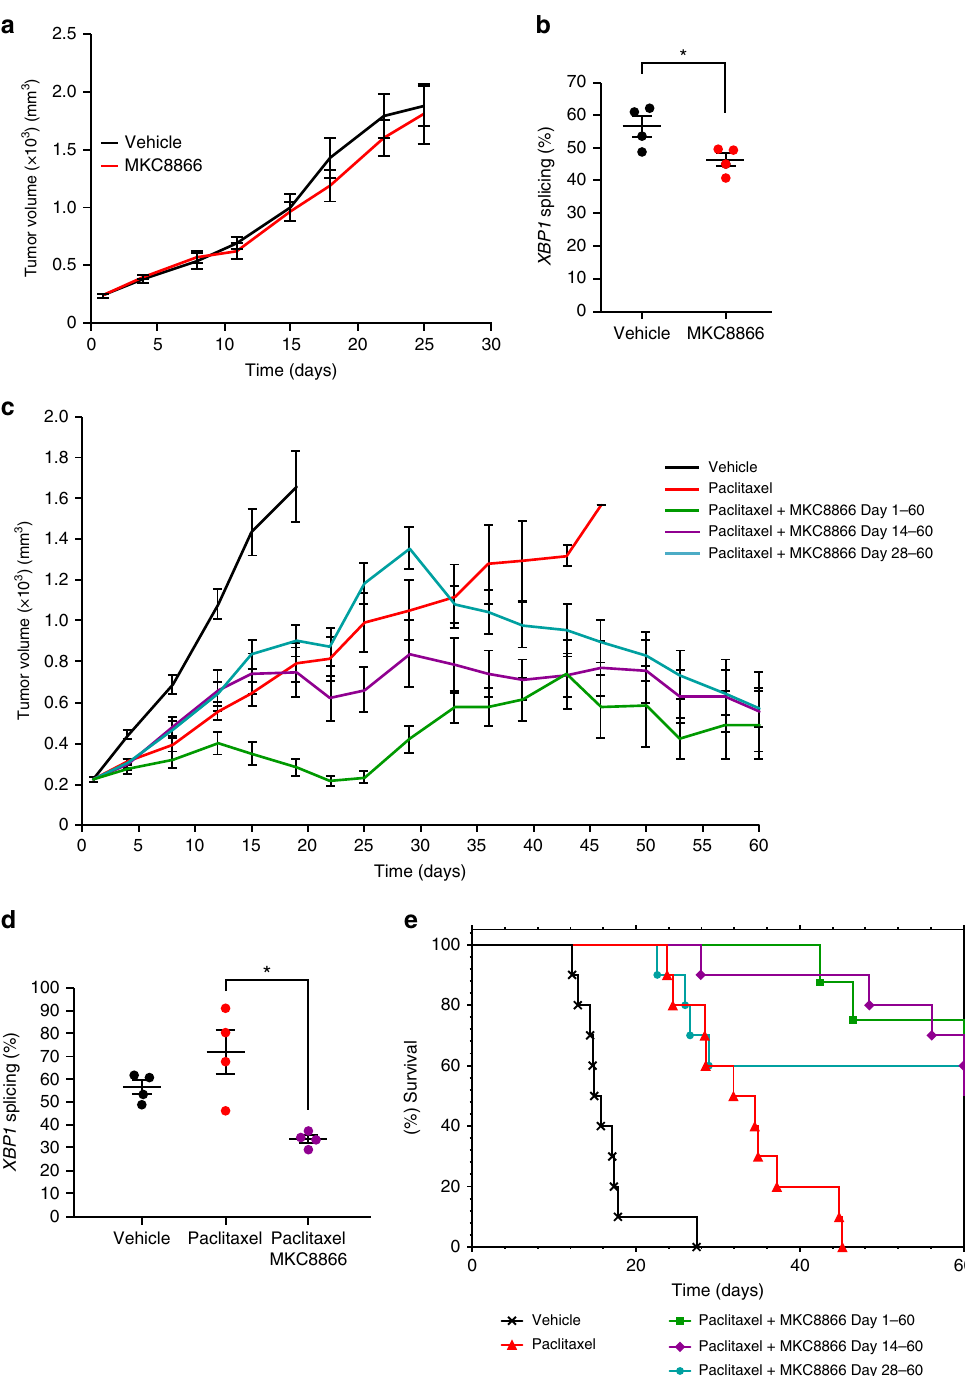
Fig. 7 MKC8866 enhances the effectiveness of paclitaxel in vivo. Xenografts were established by subcutaneously injecting 5 × 10 6 MDA-MB-231 cells into the right fl ank of female athymic nude mice (Crl:NU(Ncr)- Foxn1nu , Charles River). When tumors were palpable (250 mm 3 ) mice were randomized into groups and treatments initiated. a Vehicle-only versus MKC8866 (300 mg kg − 1 ) daily via oral gavage. Tumor size was assessed every 2 – 3 days via caliper measurement and tumor volume calculated. By day 25, all tumors had reached their maximum permitted size ( n = 10 mice per group). b Percentage XBP1 mRNA splicing was determined in vehicle-only versus MKC8866-treated xenografts ( n = 4 per treatment group). c Paclitaxel was administered weekly at 10 mg kg − 1 by intravenous injection, alone and in combination with MKC8866 administered daily at 300 mg kg − 1 by oral gavage from day 1 to 60, from day 14 to 60, and from day 28 to 60. Tumor size was assessed every 2 – 3 days via caliper measurement and tumor volume calculated ( n = 10 mice per group). d Percentage XBP1 mRNA splicing was determined in vehicle-only, MKC8866-treated and paclitaxel plus MKC8866-treated xenografts ( n = 4 per treatment group). e Kaplan – Meier plot showing survival in animals administered with MKC8866 in combination with paclitaxel (for indicated times) compared to paclitaxel alone or vehicle alone. * P < 0.05, based on a Student ’ s t test. Error bars represent